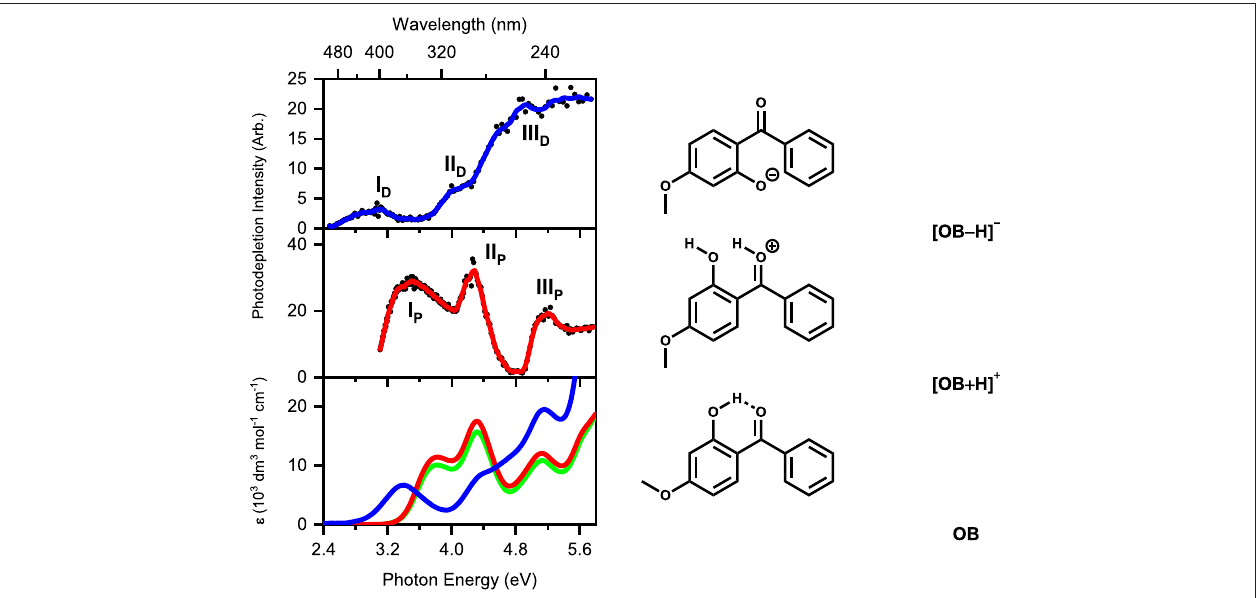
FIGURE 1 | (Top) Gas-phase photodepletion (absorption) spectrum of deprotonated oxybenzone ([OB − H] − ). (Middle) Gas-phase photodepletion spectrum of protonatedoxybenzone([OB+H] + ).Thesolidlinesarea5-pointadjacentaverageofthedatapoints.Aschematicofthelowest-energyisomersof[OB − H] − and[OB+H] + are shown alongside their respective spectra. (Bottom) Solution-phase absorption spectra of OB under alkaline (blue), neutral (green), and acidic (red) conditions. Data reproduced from (Wong et al., 2019b) with permission from the PCCP owner societies.